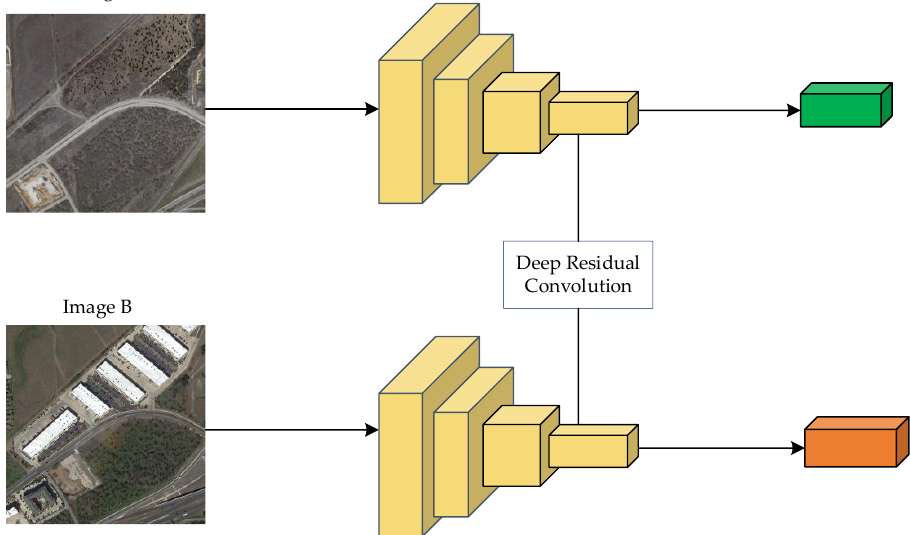
Figure 2. Siamese backbone for our change detection network.